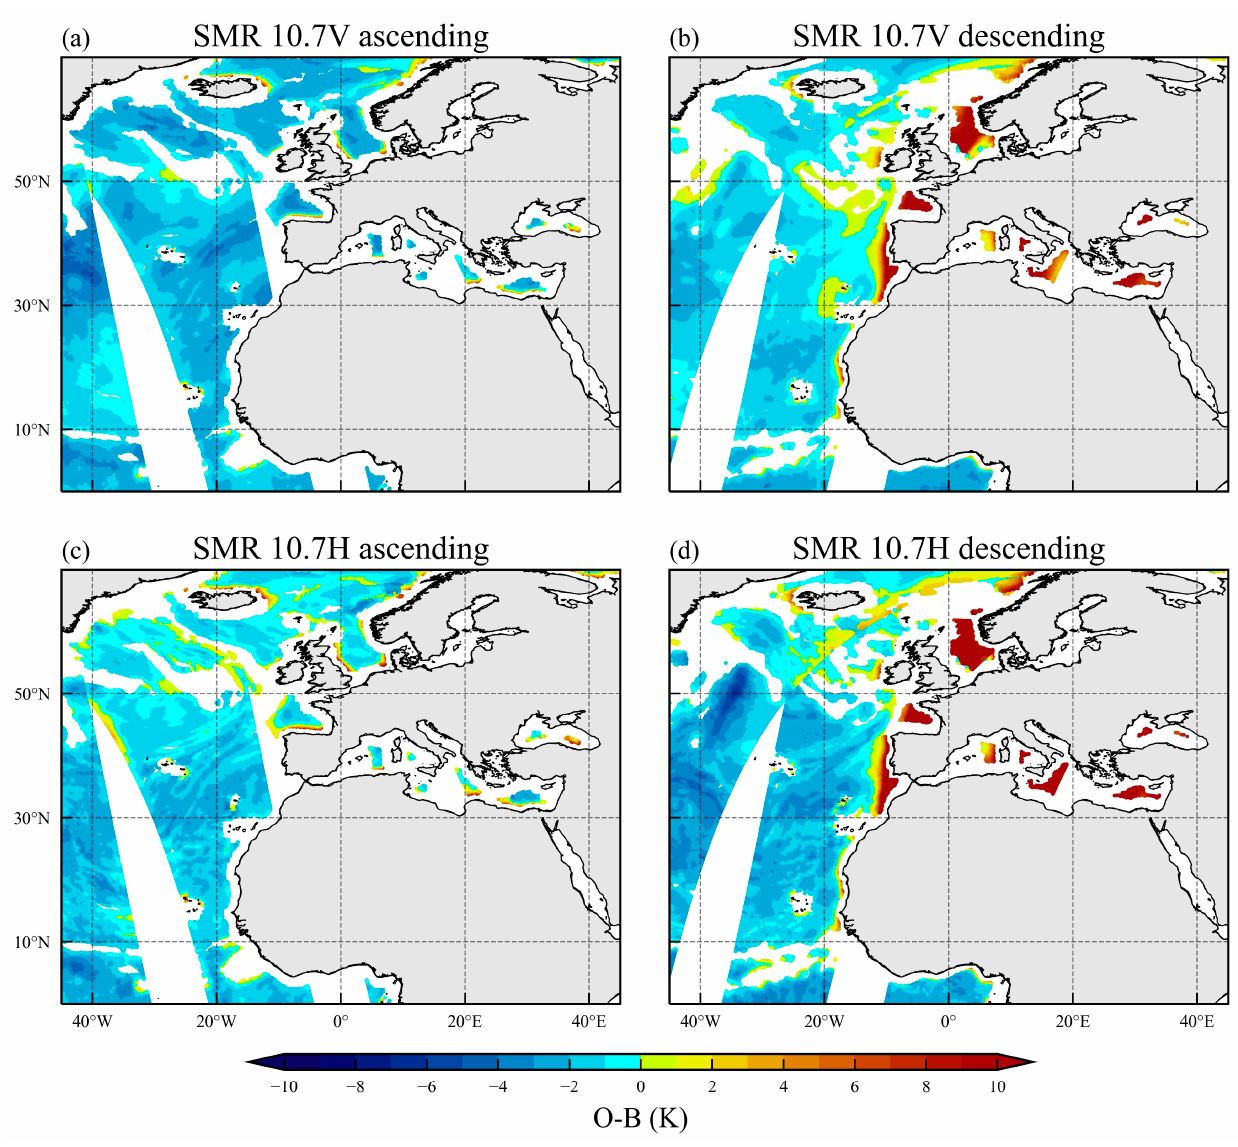
Figure 9. The spatial distribution of O-B for the SMR 10.7 GHz channels from 1200 UTC 10 July 2021 to 1200 UTC 11 July 2021, for ( a ) SMR 10.7 V channel, ascending data only, ( b ) SMR 10.7 V channel, descending data only, ( c ) SMR 10.7 H channel, ascending data only, and ( d ) SMR 10.7 H channel, descending data only. O-B statistics are based on NCEP-GFS, and the latitude check was not considered here.